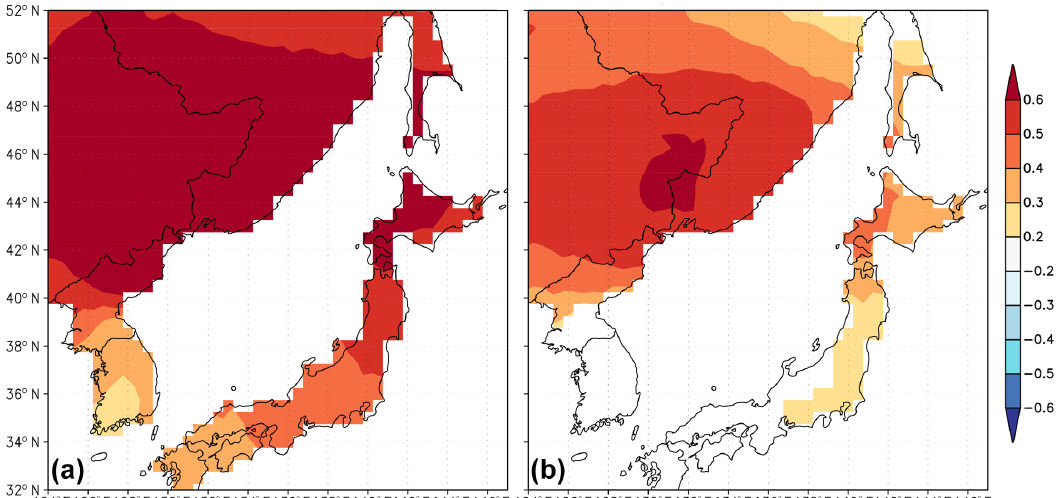
Figure 7. Spatial correlations between the observed (a) and reconstructed (b) August–December minimum temperature (VUS) in this study and regional gridded annual minimum temperature from CRU TS 4.00 over their common period of 1960–2003 ( p